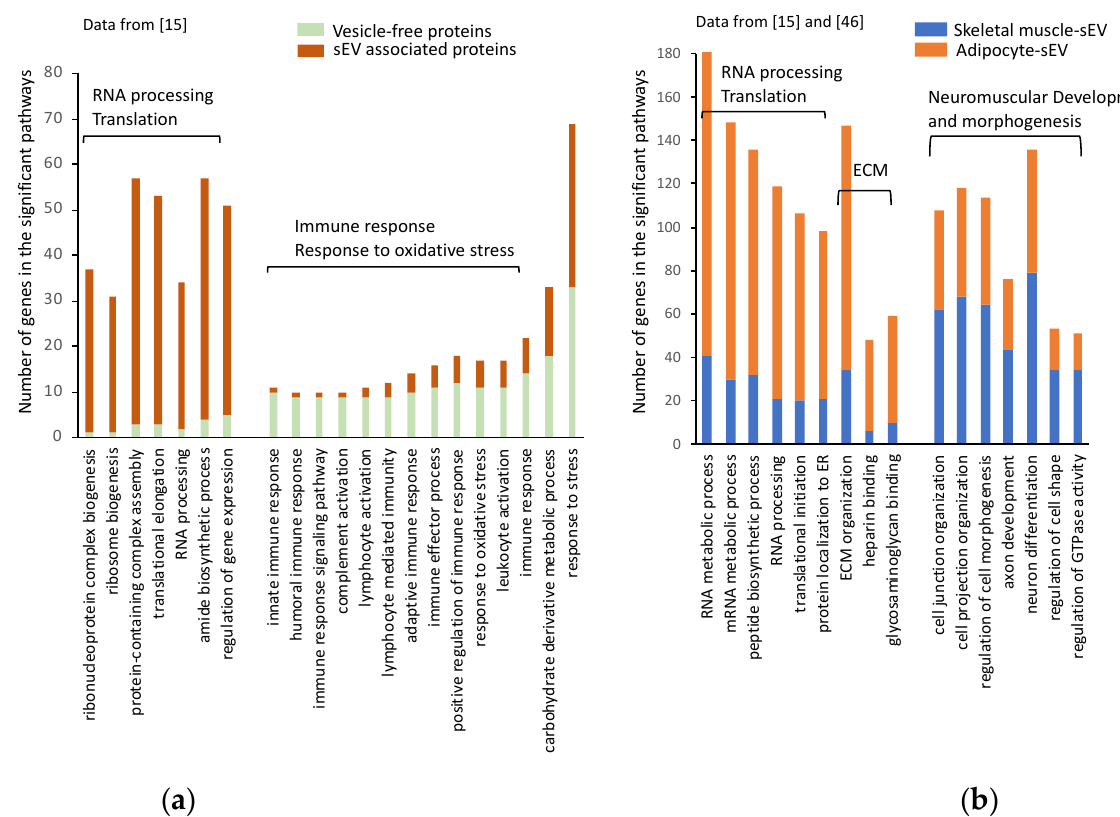
Figure 3. Adipocytes export a specific subpopulation of proteins into adipocyte-derived extracellular vesicles (AdEVs). ( a ) Significant GO biological functions enriched in proteins released in the conditioned medium from human differentiated adipocytes, either packed inside small extracellular vesicles or being released under a vesicle-free form. Proteomic data are from [15]. ( b ) Significant GO biological functions enriched in small EV (sEV) protein subsets released from human adipocytes vs. those released from human myotubes. Proteomic data are from [15] and [45]. Only functions containing more than 50 genes are presented. ECM, extracellular matrix; ER, endoplasmic reticulum. For ( a ) and ( b ), the significantly enriched pathways were retrieved using PANTHER version 11 [46].